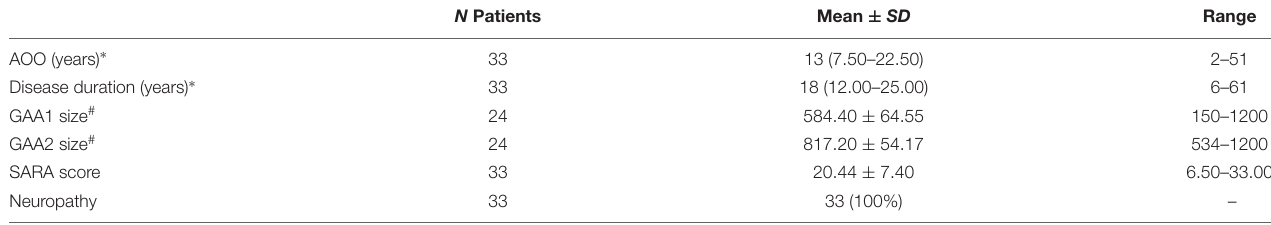
TABLE 2 | Summary of clinical characteristics.